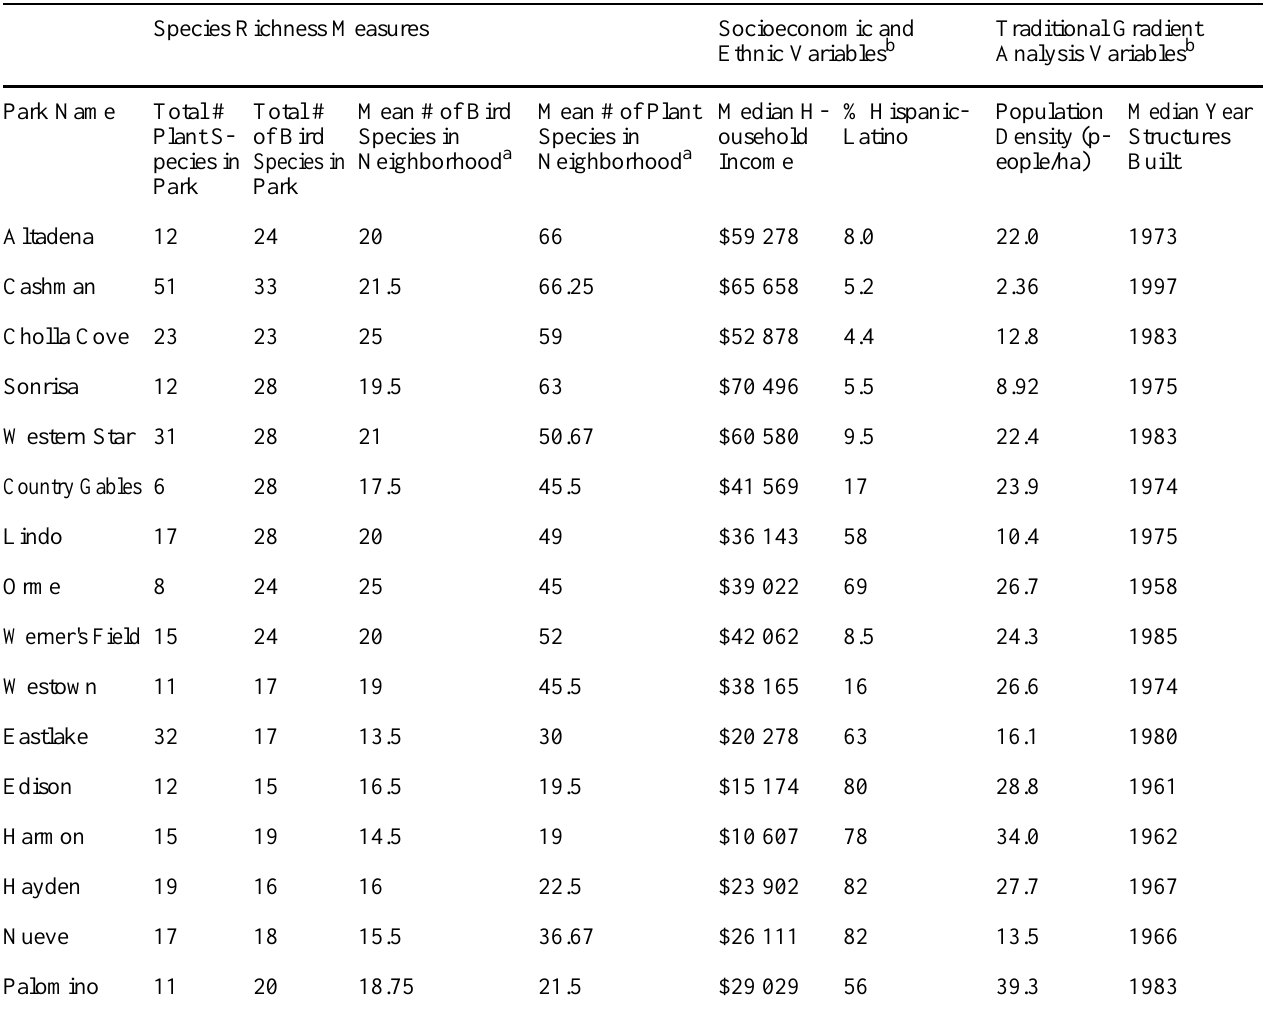
Table 2. Summary data for the 16 parks, including species-richness data and independent variables used in the statistical